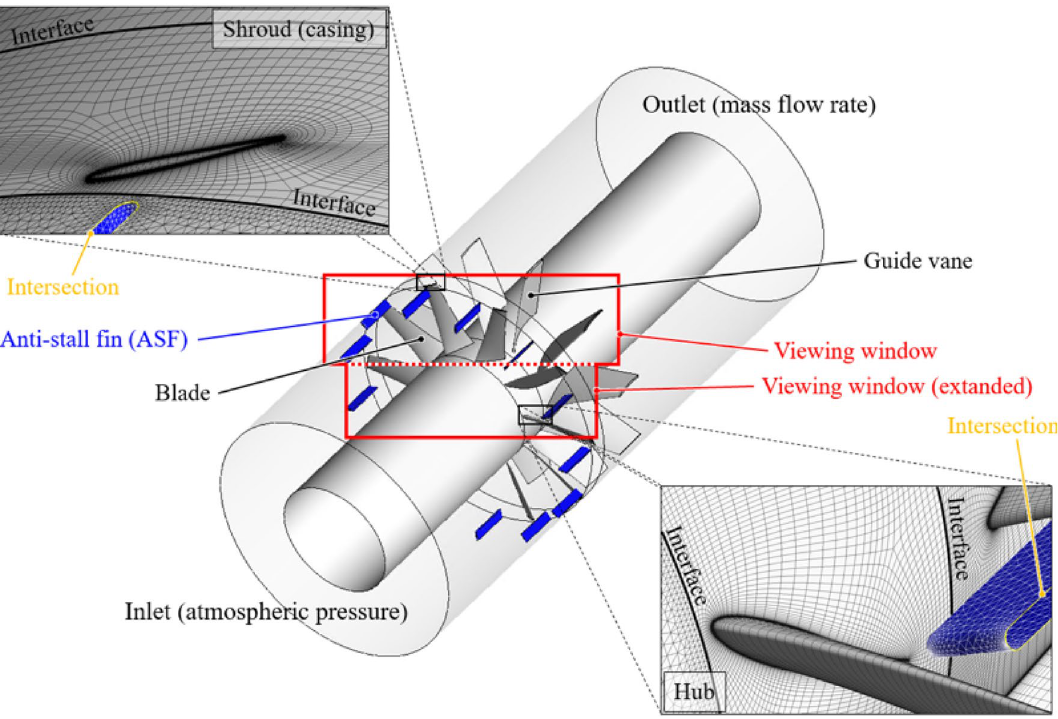
Figure 4. Computational domain and grid system with viewing window for post process.